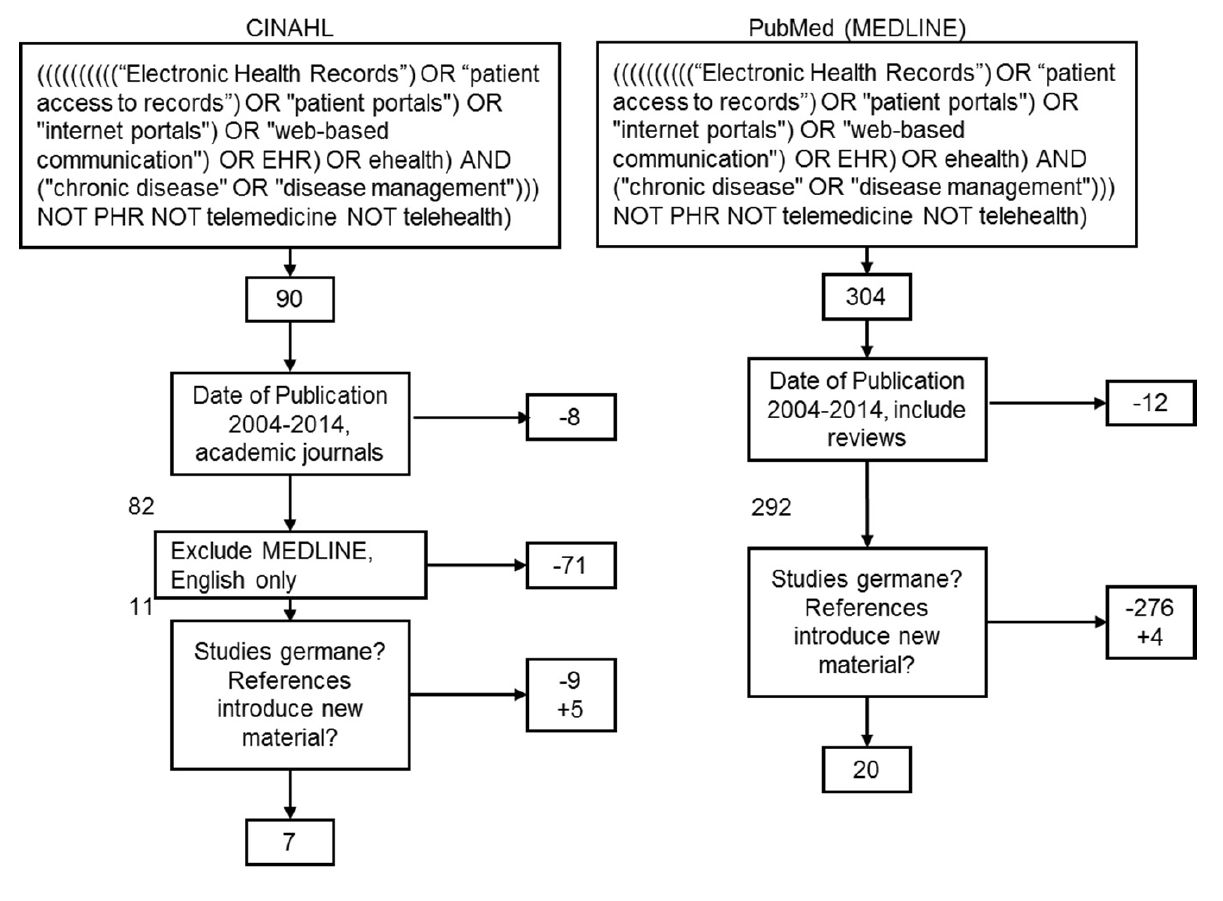
Figure 1. Literature review